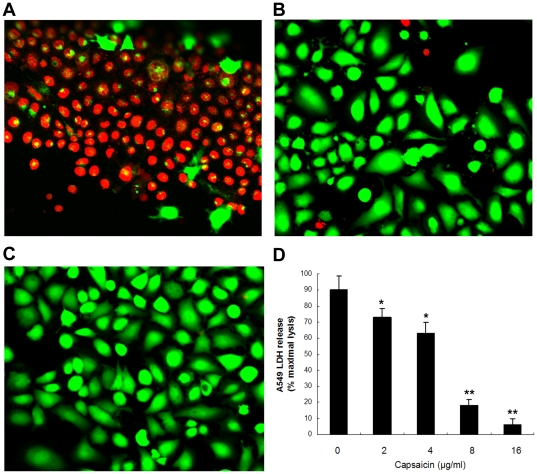
Capsaicin prevents human alveolar epithelial cells from S. aureus induced injury.Live (green)/dead (red) staining of A549 alveolar epithelial cells was imaged using confocal laser scanning microscopy at 6 h after infection with S. aureus. The cells were co-cultured with S. aureus USA300 in medium (A), co-cultured in the presence of 16 µg/ml of capsaicin (B), or uninfected (C). (D) LDH release by A549 cells was determined using cells co-cultured with S. aureus USA300 supplemented with the indicated concentrations of capsaicin. The values in panel D represent the average ±SD of three independent experiments. A single asterisk (*) indicates P<0.05 and two asterisks (**) indicate P<0.01 as compared with the capsaicin-free co-culture.